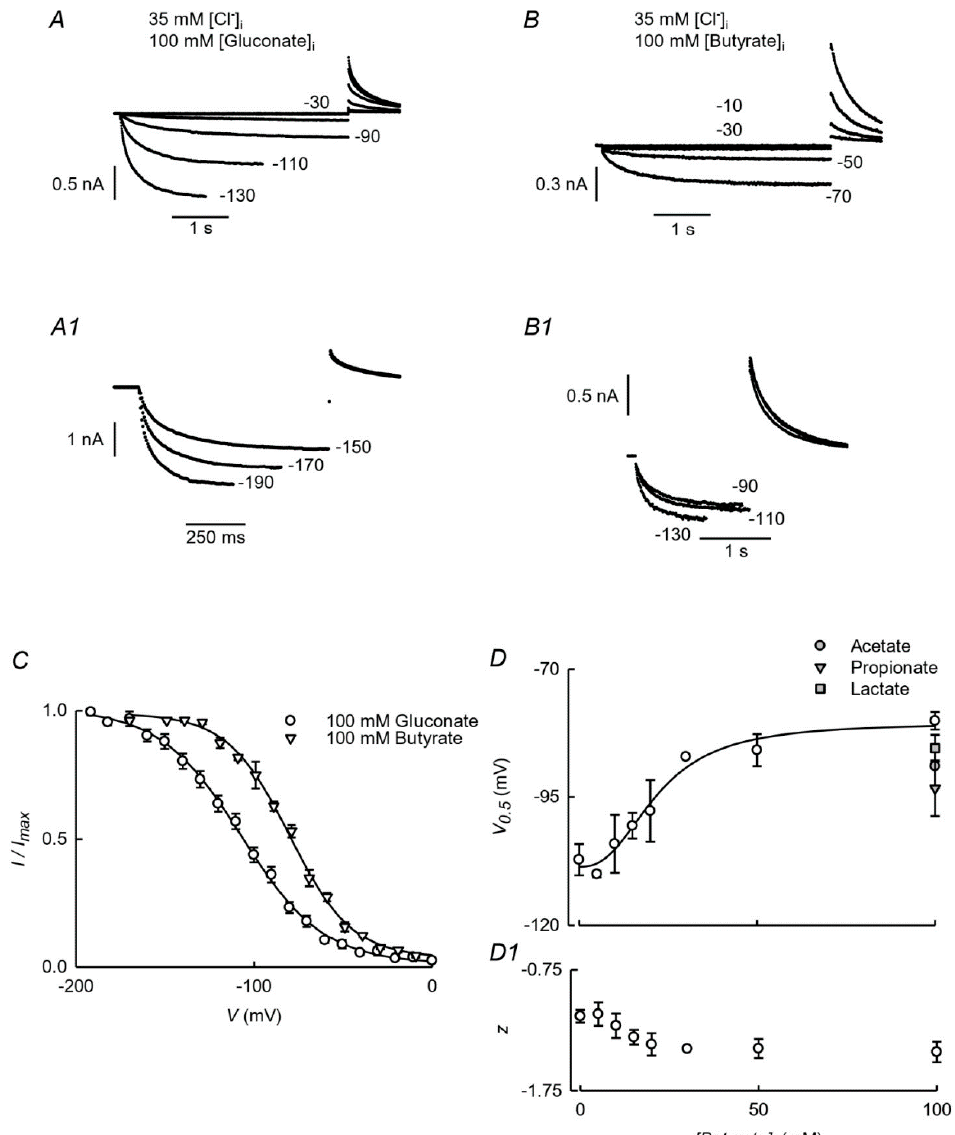
Figure 1. E ff ect of intracellular butyrate on ClC-2 currents. ( A ) and ( A1 ): current traces mediated by ClC-2 elicited from a holding potential V h of 0 mV in response to test pulses to the indicated potentials. Main activating pulses were followed by a pulse to 30 mV. The duration of the main activating pulses was increased at more positive voltages in order to approximate full activation of the conductance. The beginnings of the tail currents at 30 mV were moved to align them in the time axis. The intracellular solution contained 35 mM Cl − and 100 mM gluconate. The bath solution contained 146 mM Cl − . Full details of the solution composition are given in the Methods section. ( B ) and ( B1 ): as A and A1 but with 100 mM butyrate replacing gluconate in the intracellular solution. ( C ): Normalised tail currents, giving an estimation of apparent open probabilities, calculated as described in the text are given for experiments as those in A and B sections. The continuous lines are fits of Boltzmann distributions to the data (means ± SEM, n = 7 and 5 for experiments in gluconate and butyrate respectively). V 0.5 ( D ) and slope factor ( D1 ) parameters derived from the Boltzmann fits at various intracellular butyrate concentrations. Experiments obtained with 100 mM acetate, propionate and lactate in the pipette solution are also shown in D . Data are means ± SEM of 2–9 experiments.